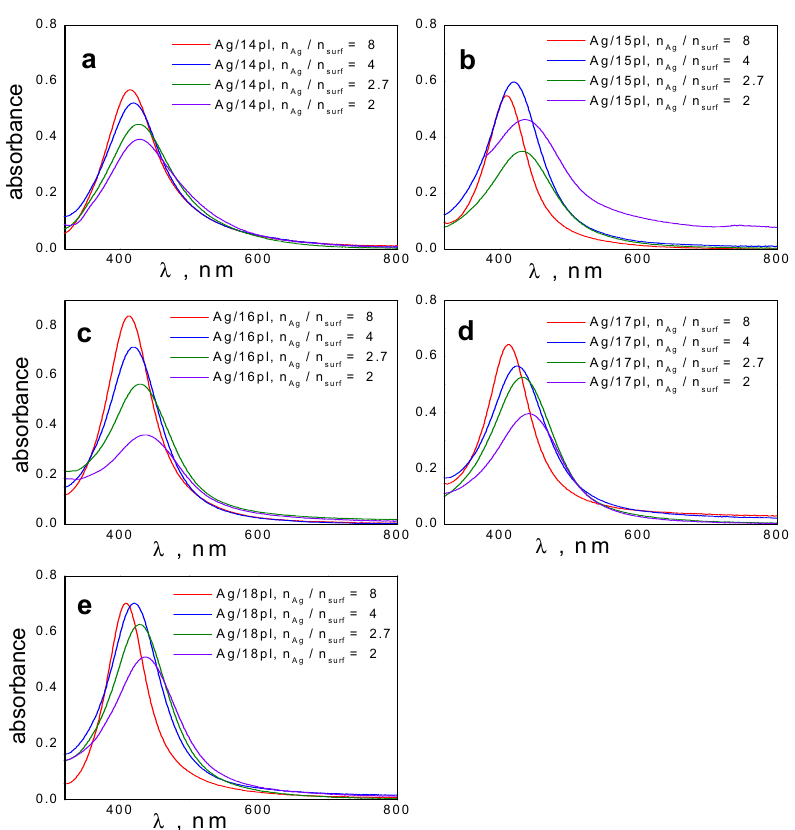
both peak position and maximum absorbance change with varying silver-to-surfactant molar ratio n Ag /n surf surf between the values 2 and 8.